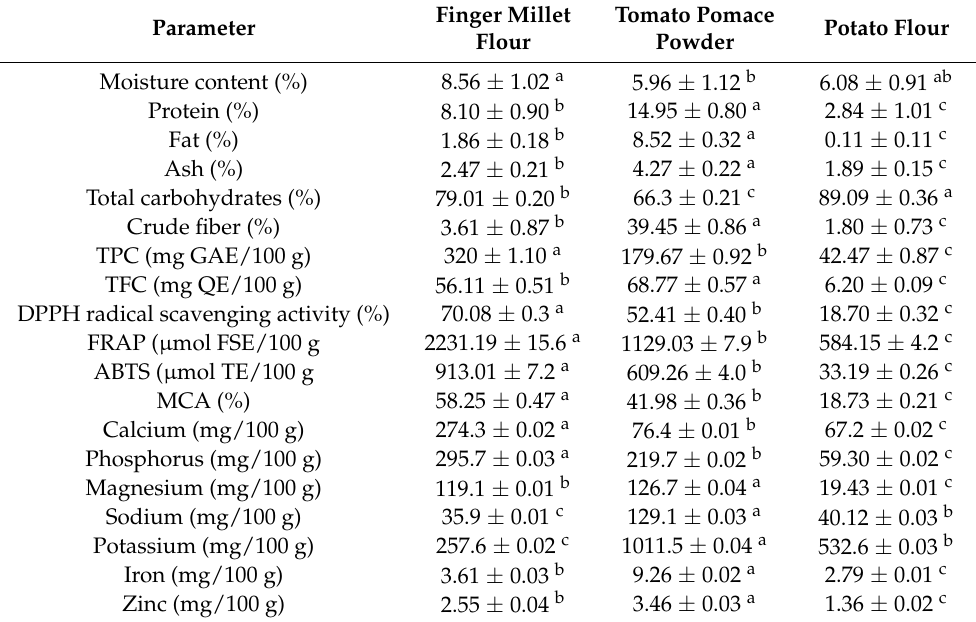
Table 2. Physico-chemical and phytochemical composition of major raw materials. Parameter